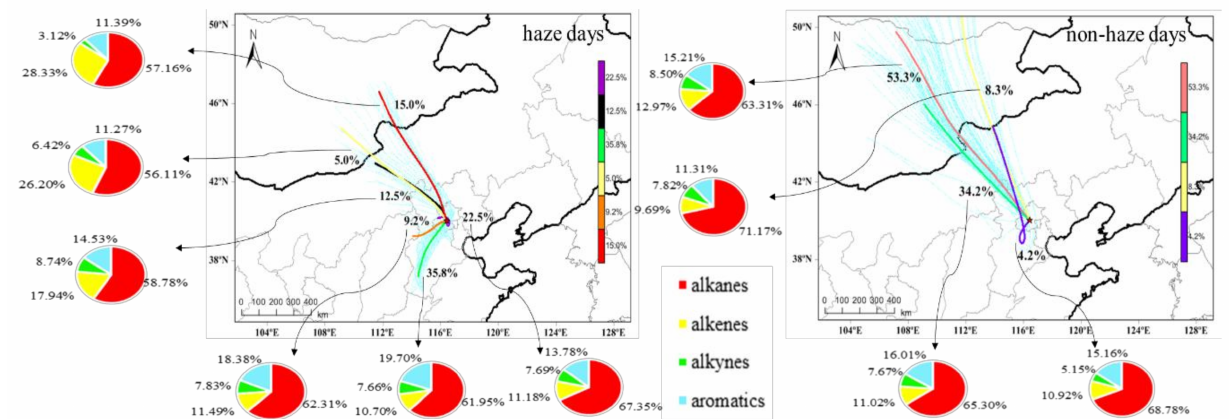
Figure 6. The 24 h backward trajectories from CRAES during haze and non-haze days.